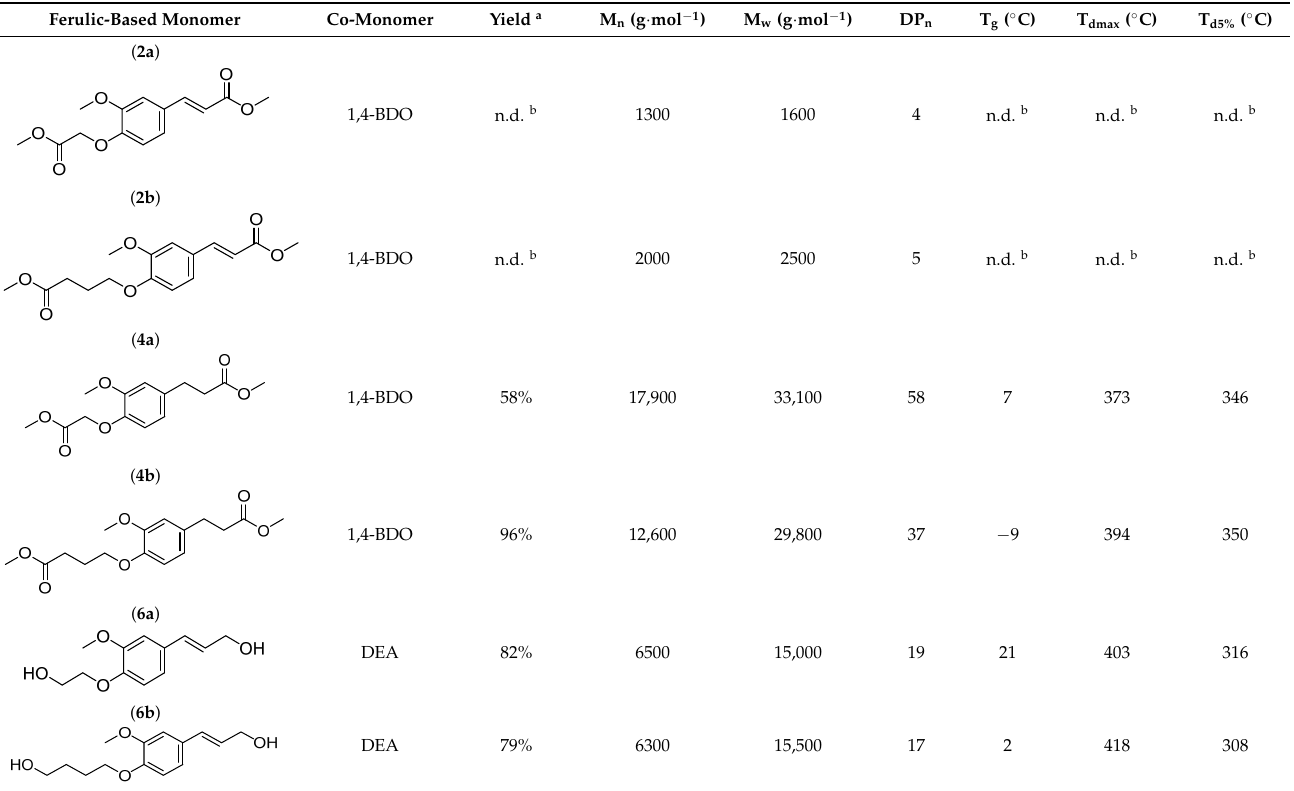
Figure 1. NMR spectra in CDCl 3 of the ferulic-based diesters and their corresponding polyesters: ( a ) 2a and 3a ; ( b ) 2b and 3b . Table 1. Main properties of the enzymatically synthesized polyesters.